Question: Which kind of chart has been used to present this data?
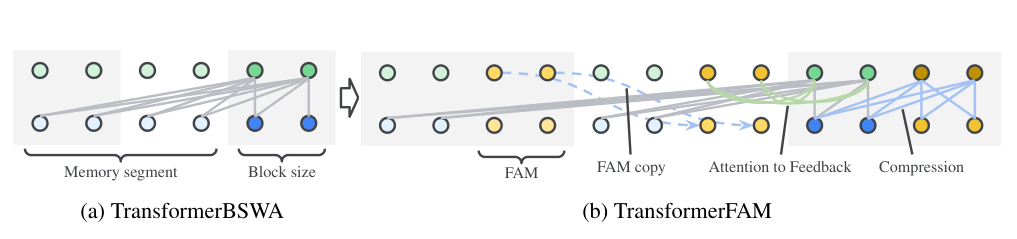
Answer: line